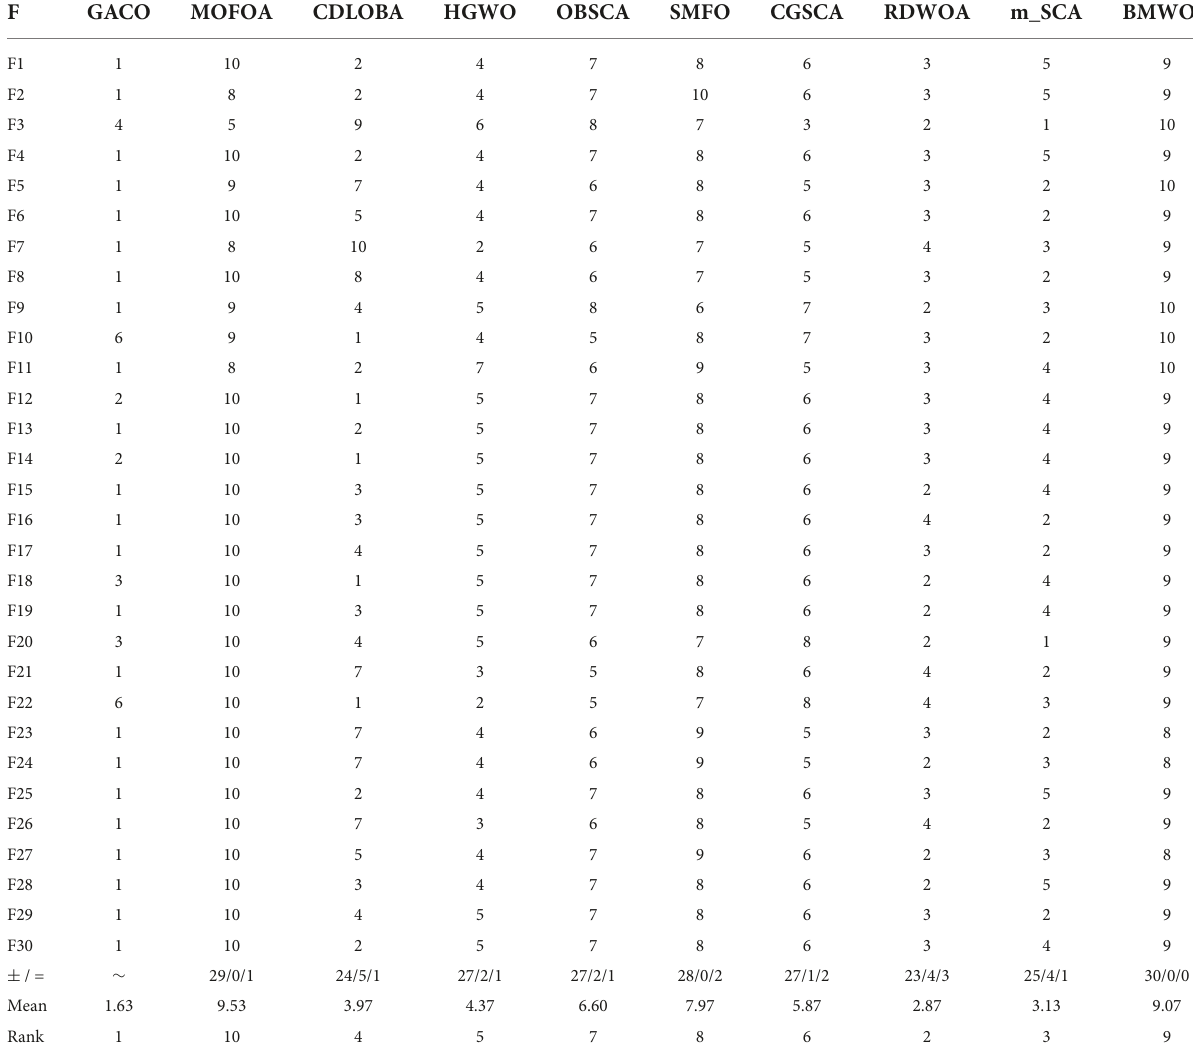
TABLE 9 The ranking of all algorithms on each function and the Wilcoxon signed-rank test result. F